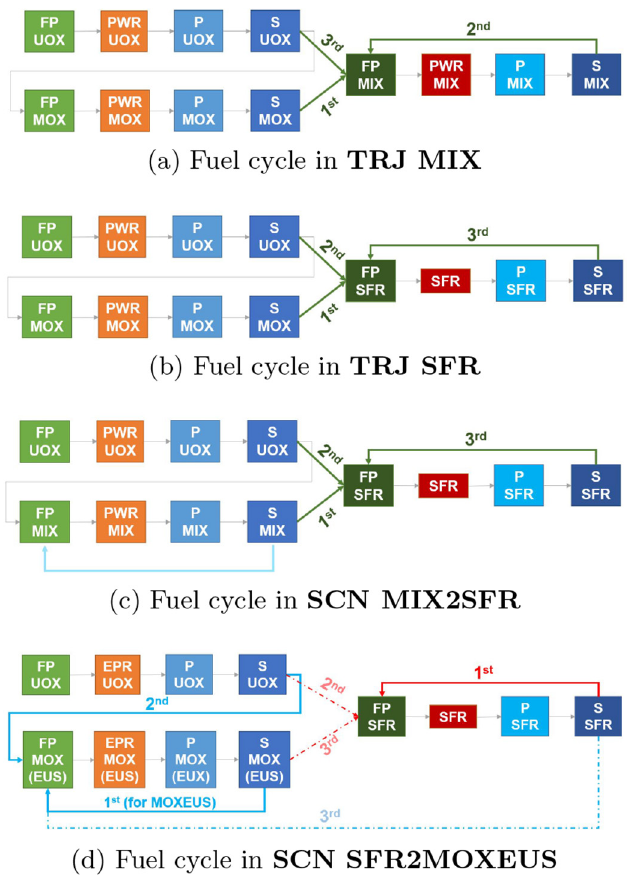
Fig. 1. Fuel cycles of interest in TRJ MIX , TRJ SFR , SCN MIX2SFR and SCN SFR2MOXEUS . The acronyms in the figures: FP means fabrication plant, P means cooling pool, S means interim stock for spent fuels after necessary cooling. Arrows highlighted with orders stand for the priority of spent fuel reprocessing to recycle the plutonium for the advanced fuel